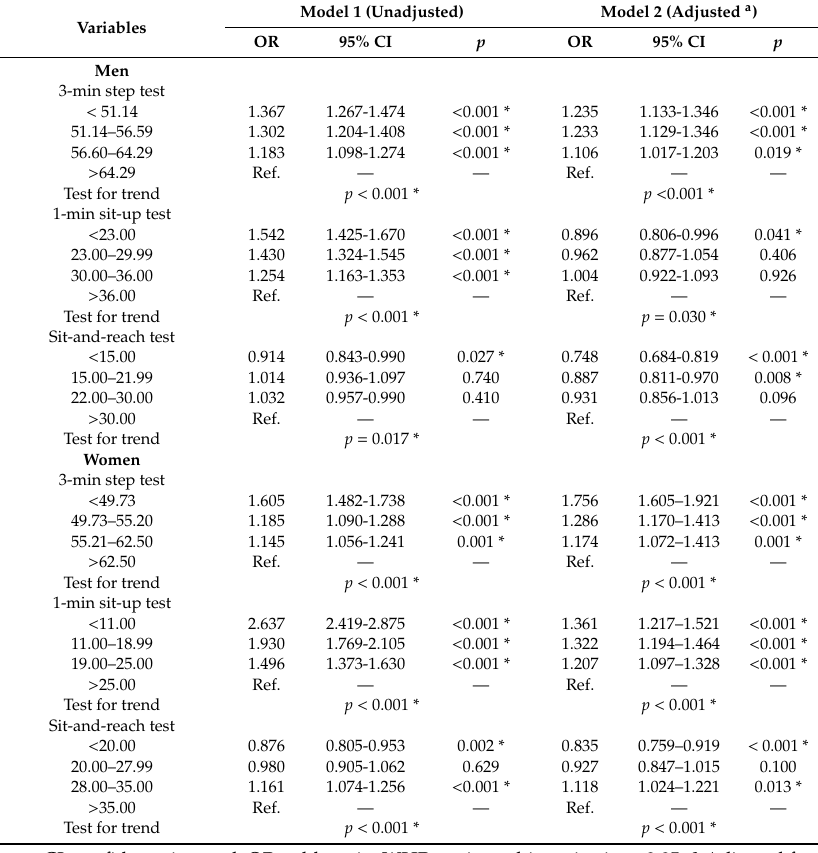
Table 4. Multivariate adjusted odds ratios (ORs) for overweight in relation to quartiles of health-related physical fitness measurements after adjustment for potential